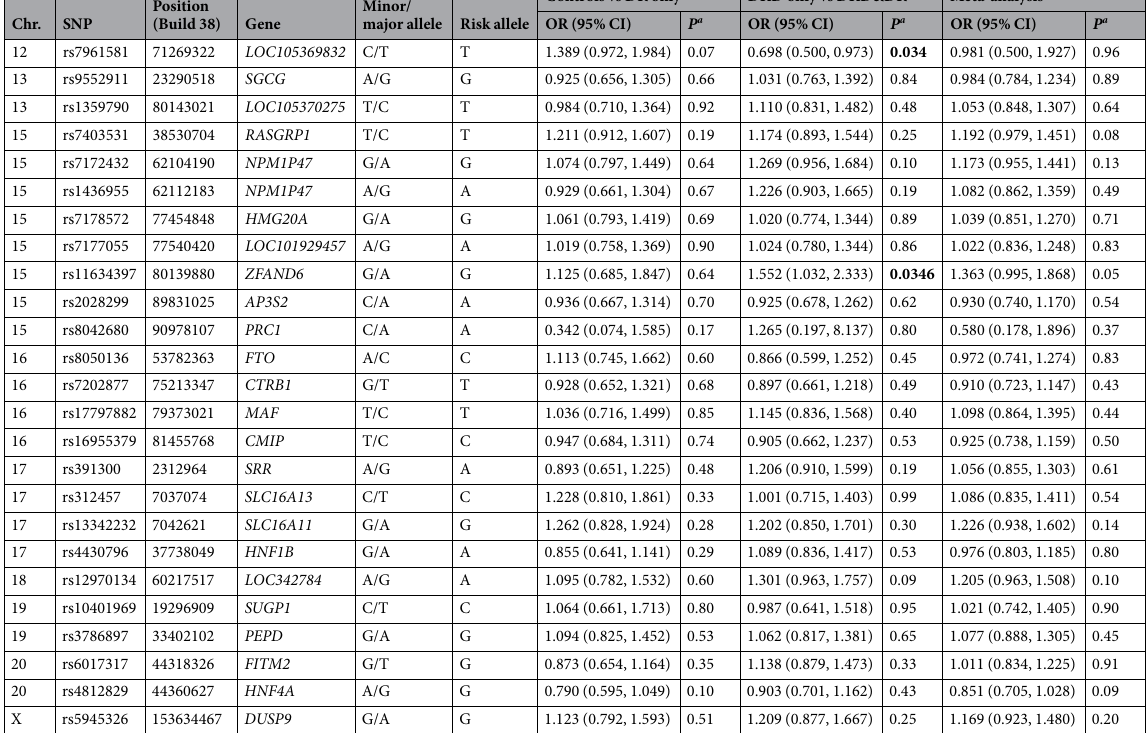
Table 1. Effects of the SNPs on DR in stage 1 samples. DKD = diabetic kidney disease; DR = diabetic retinopathy. P values < 0.05 are shown in bold. a Adjusted for duration of diabetes, HbA 1c , systolic blood pressure, diastolic blood pressure, body mass index under an additive model. The OR with 95% CI shown is for the minor